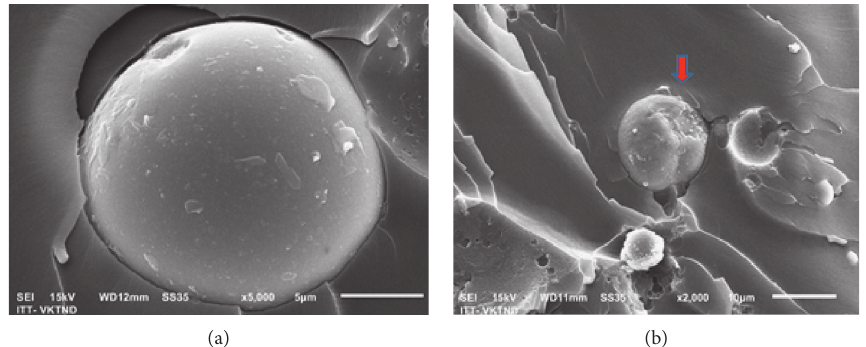
Figure 4: SEM images of nanocomposites: 40 wt.% fly ash/0.04 wt.% MWCNTs/epoxy ((a),